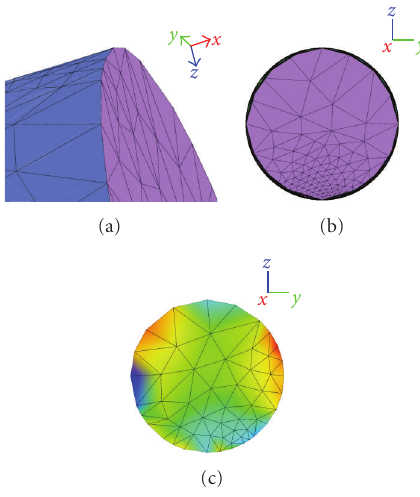
Figure 5: Projection to the defining curve of the patches frontier. (a) Detail of the channel exit. (b) Front view of the channel exit. (c) Relative solution with correct results.